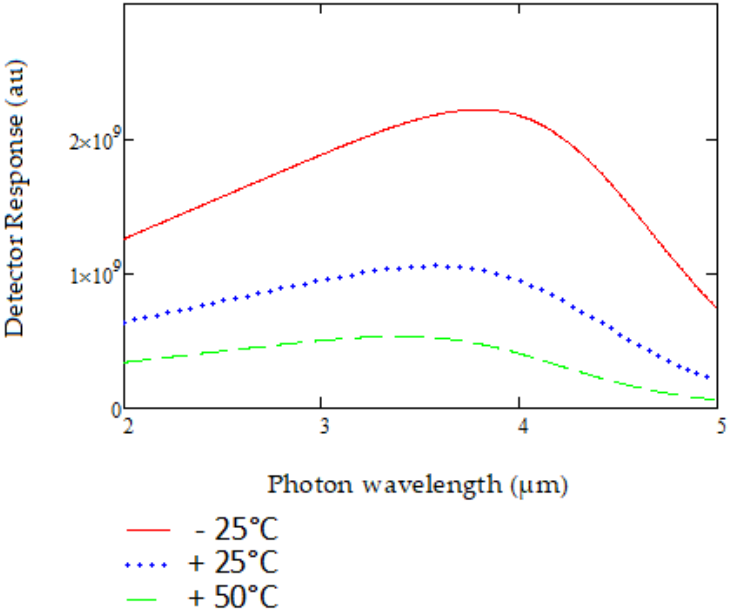
Figure 7. Lead selenide detector response modelled at di ff erent temperatures in the 2 to 5 µ m range.